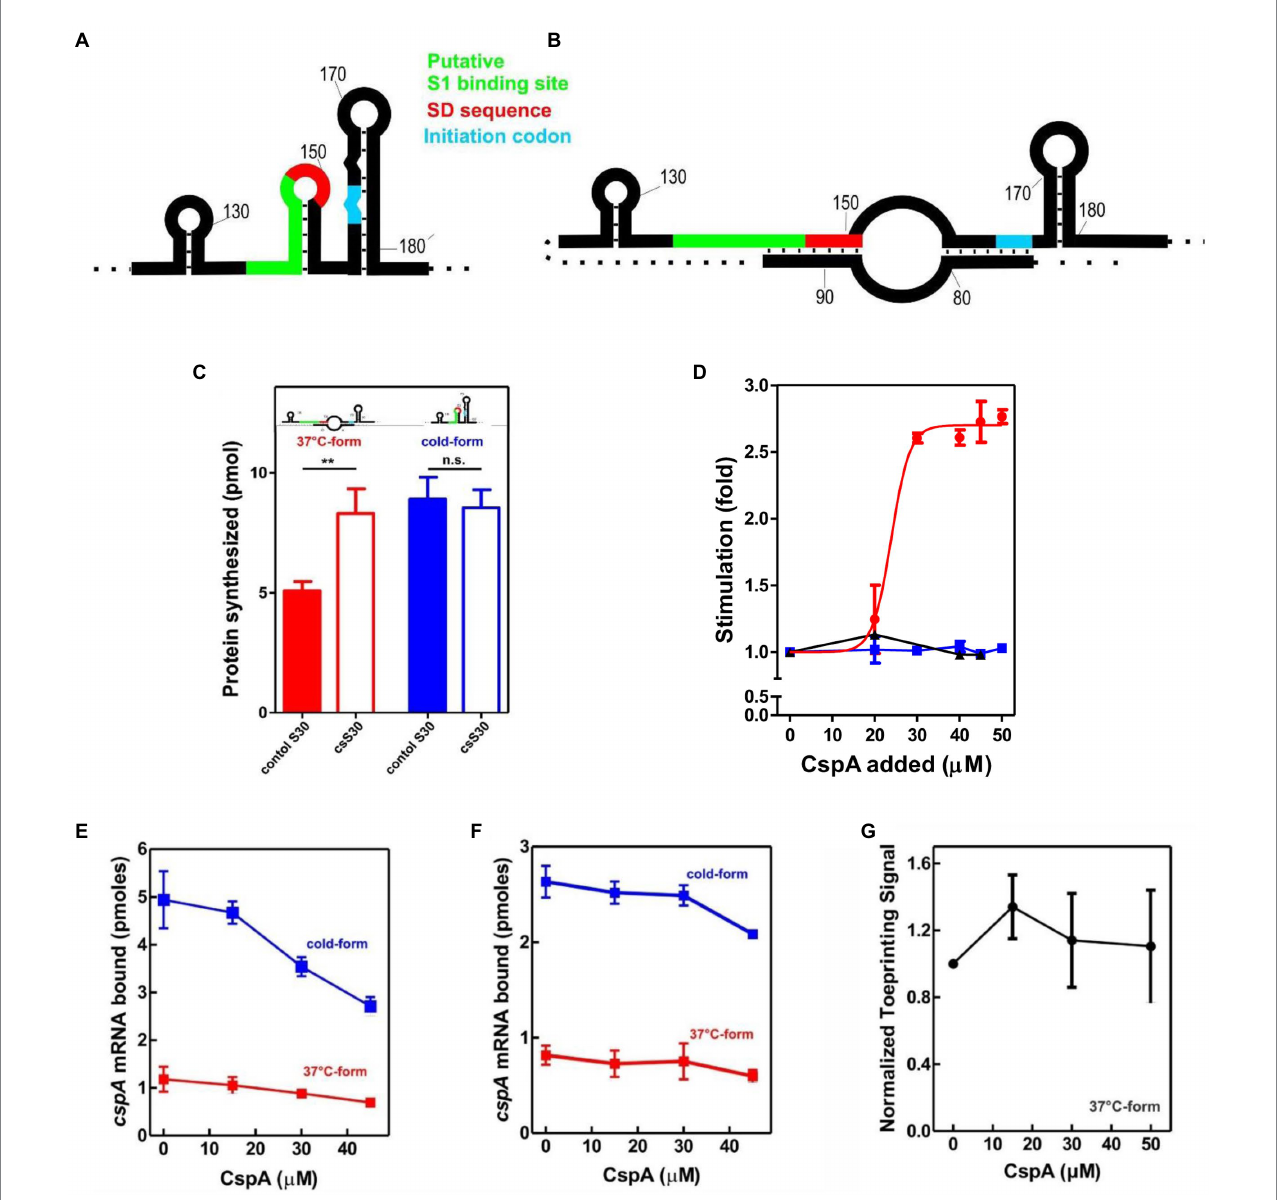
FIGURE 1 Effect of CspA on cspA mRNA translation at low temperature. Schematic representation of the secondary structures of the Translation Initiation Region (TIR) of the (A) cold-form and (B) 37 ° C-form of cspA mRNA. The SD sequence, the start codon and the putative S1-binding site are indicated in red, light blue, and green, respectively (Giuliodori et al., 2010). (C) In vitro translation with control (solid bar) and cold-shock (open bar) S30 extracts; the experiment was carried out with cspA mRNA folded in the cold-form (blue bar) or in the 37 ° C-form (red bar). Samples were taken 15 min after incubation at 15 ° C. The data are the average of four experimental points and the error bars represent the standard error. (D) In vitro translation with control 70S and S100 in the presence of the indicated amounts of purified CspA at 15 ° C with the cold-form (blue) or the 37 ° C-form (red) of cspA mRNA. The reaction was also performed at 37 ° C only with the 37 ° C-form (black line). The data points are the average of two independent experiments and the error bars represent the standard error. The effect of increasing amounts of CspA on the binding of cspA mRNA on the 30S subunits was monitored at 15 ° C by filter binding of 32 P-labelled cspA mRNAs folded in the cold-form (blue) or in the 37 ° C-form (red) in the absence (E) or in the presence (F) of IFs and fMet-tRNA iMet . The effect of increasing amount of CspA on the initiation phase of translation at 15 ° C was also investigated by analyzing (G) the localization of 30S on the translation start site of cspA mRNA by toeprint assay. The data points in panels (E) and (F) are the average of triplicates. The data points in panel (G) result from the quantification of toeprint signals of two independent experiments. Error bars represent the standard error. Further details are given in “Materials and